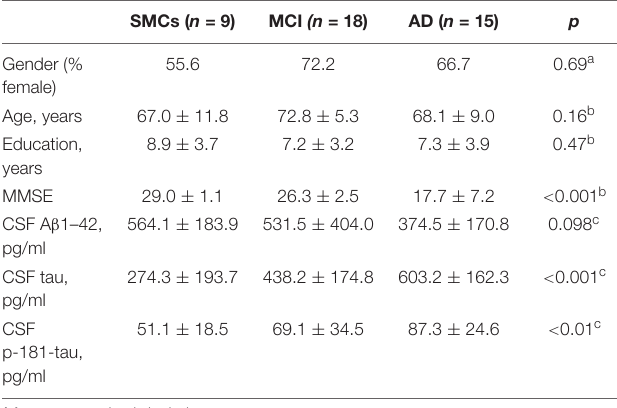
TABLE 1 | Demographic, clinical, and biochemical characteristic in the three study